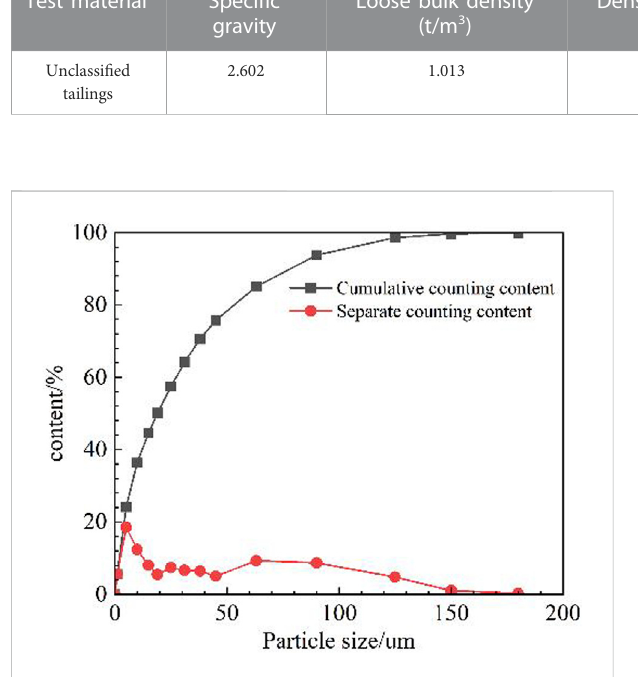
FIGURE 1 Separate and cumulative counting particle size curve of ultra fi ne particle unclassi fi ed tailings.